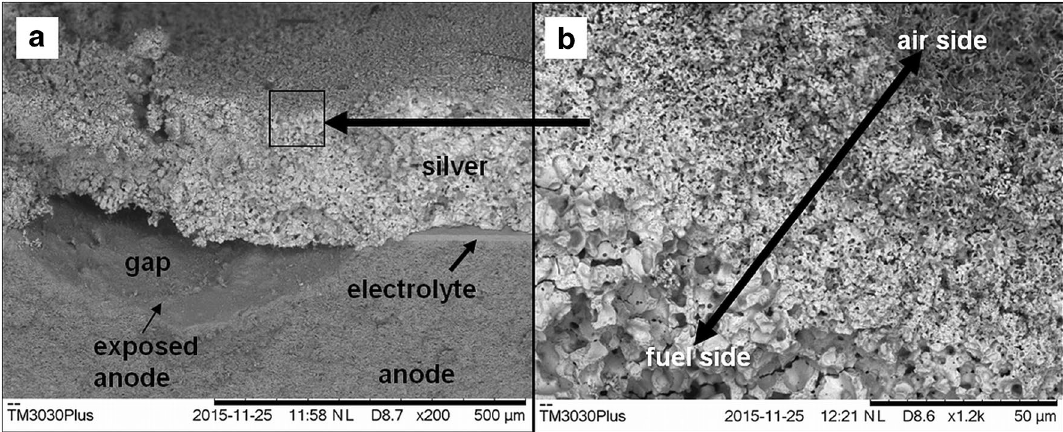
Fig. 3 SEM scans: a the cross-section of the anode current connection (Ag-YSZ-Ni/YSZ, 8 h at 700 °C); a visible gap formed between the anode and the silver sealant; b the cross-section of silver sealant near the air